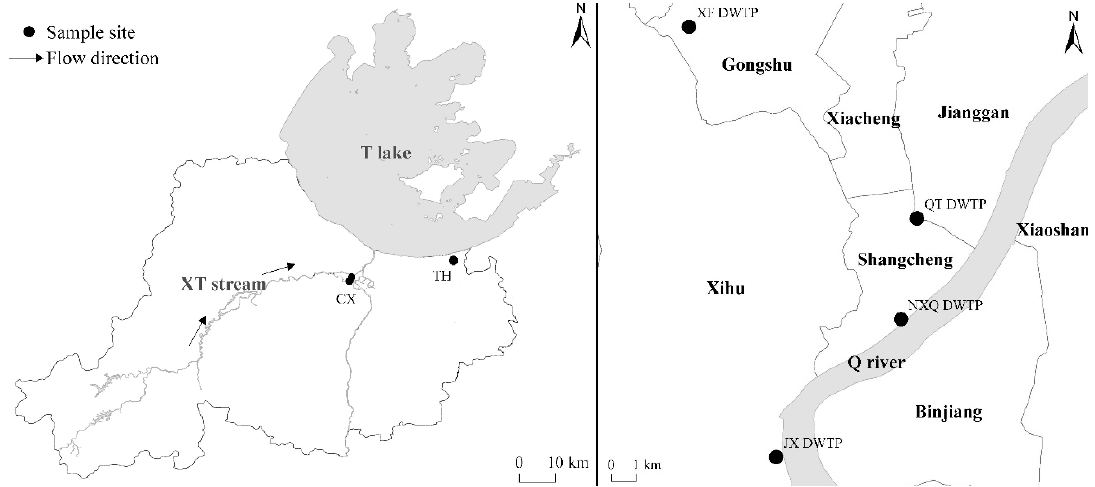
Figure 1. Map of the sampling sites. (DWTP = drinking water treatment plant). Table 1. Water quality of sampled waters.